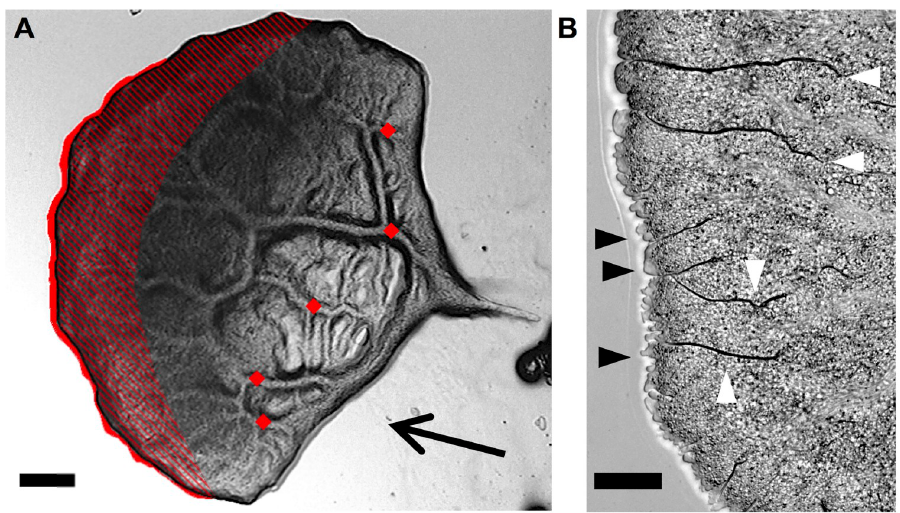
Fig 18. Volumetric flow rates and micromorphology in a migrating mesoplasmodium. A) Migrating mesoplasmodium. Scale bar = 200 μ m. Overlay of two images taken at an interval of � 3 min. From the solid red area, we calculated the overall volumetric flow rate (which corresponds to I internal veins at which flow rates were measured and which correspond to I Higher resolution of the front of a migrating mesoplasmodium. Scale bar = 50 μ m. White arrows point to membrane folds, black arrows to blebs.